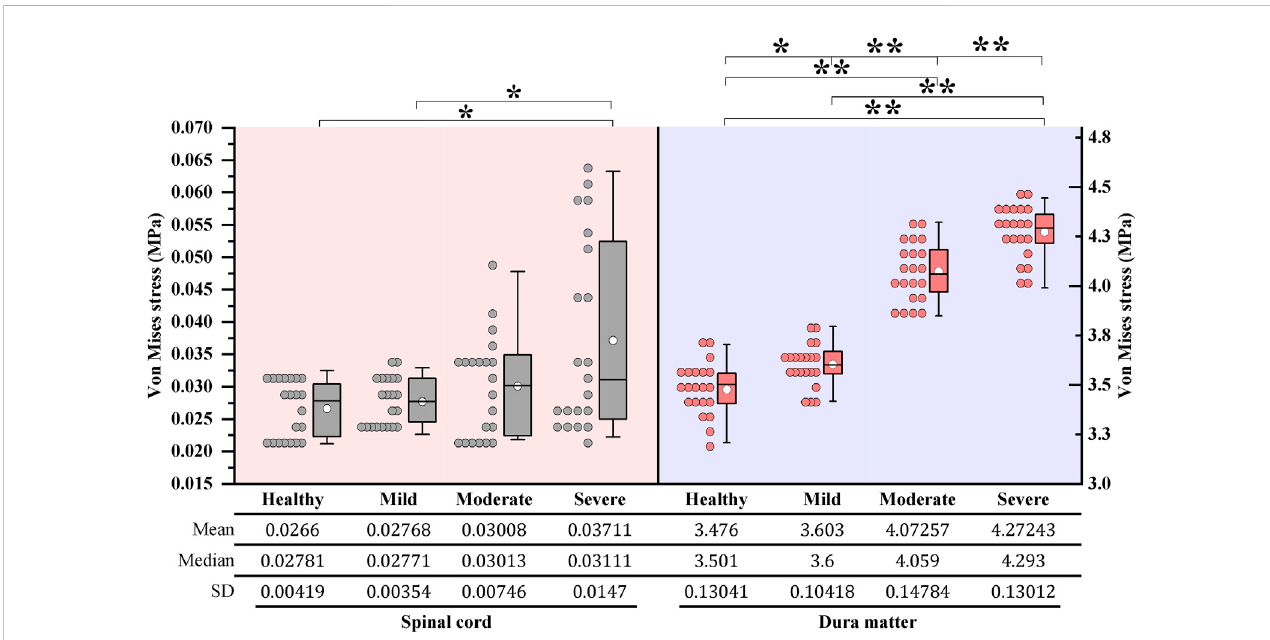
FIGURE 3 Boxplots of the von Mises stress of the cervical spinal cord and dura matter during CRM: One maximum stress data was measured for each increment under 4 ° z -axis rotation during CRM. On each box, the central thick line indicates the median, the white circle marker indicates the mean, and the top and bottomedgesindicatethe75thand25thpercentiles,respectively.Thewhiskersextendingtothemaximumandminimumvaluesdonotconsideroutliers.* p < .05, ** p < .001. (CRM, cervical rotatory